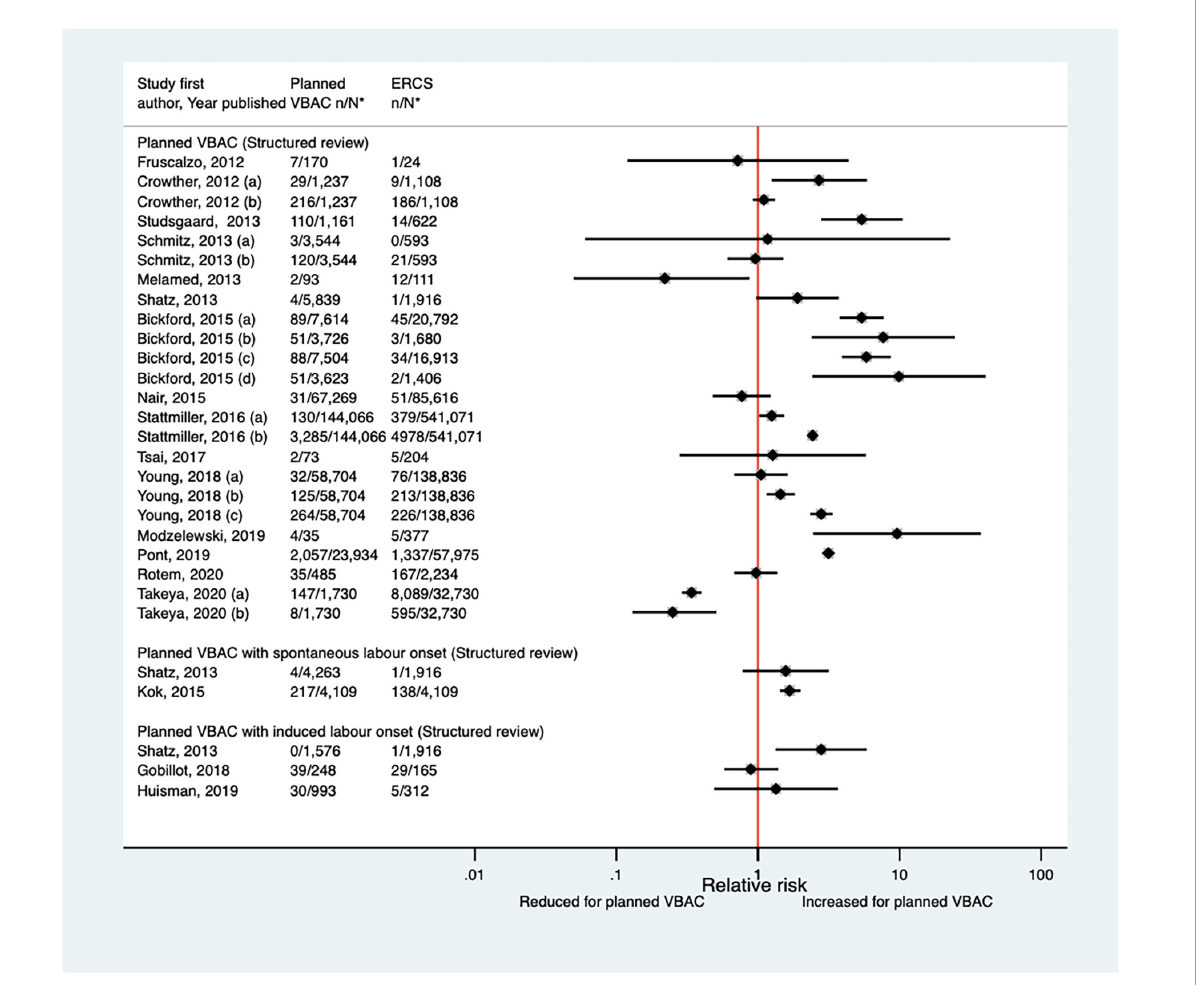
FIGURE3 Risk of hemorrhage for planned VBAC vs. ERCS. ∗ n , number in group with the outcome; N , Total number in group. Crowther et al. (33) (a) outcome: blood loss ≥ 1,500 mL and/or requiring blood transfusion, (b) outcome: blood loss > 500 mL; Schmitz et al. (46) (a) outcome: surgery (compression sutures, artery ligation, and hysterectomy) for postpartum hemorrhage, (b) outcome: prostaglandins for postpartum hemorrhage; Stattmiller et al. (55) (a) risk in women with 1–2 prior CSs only, (b) risk in women with 1–2 prior CSs and ≥ 1 prior VB, (c) risk in women with 1 prior CS only, (d) risk in women with 1 prior CS and ≥ 1 prior VB; Stattmiller et al. (55) (a) outcome: severe postpartum hemorrhage requiring hysterectomy, (b) outcome: severe postpartum hemorrhage; Young et al. (64) (a) outcome: postpartum hemorrhage requiring hysterectomy, (b) outcome: postpartum hemorrhage requiring procedures to control bleeding, (c) outcome: postpartum hemorrhage requiring blood transfusion; Takeya et al. (73) (a) outcome: hemorrhage, defined as ≥ 1,000 mL, (b) outcome: hemorrhage, defined as ≥ 2,000 mL. CS, cesarean section; ERCS, elective repeat cesarean section; VBAC, vaginal birth after previous cesarean; VB, vaginal